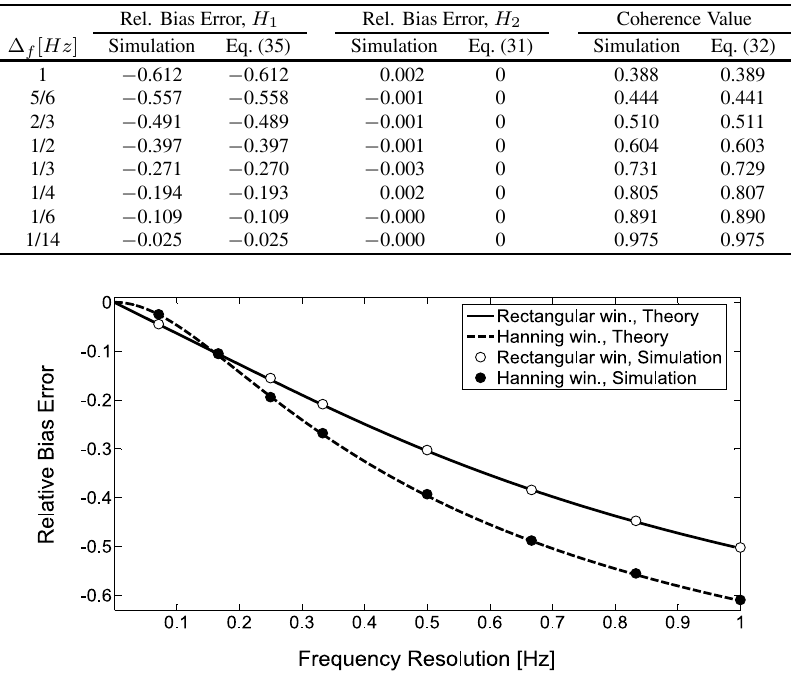
Fig. 5. An FRF is calculated from simulated time-responses for a single-degree-of-freedom system. The result is compared with the true FRF and the relative bias error at the resonance is determined. This is done for both the rectangular window and the Hanning window using the H 1 -formulation. Numerical results, which agree well with the proposed bias expressions, are shown with increasing frequency